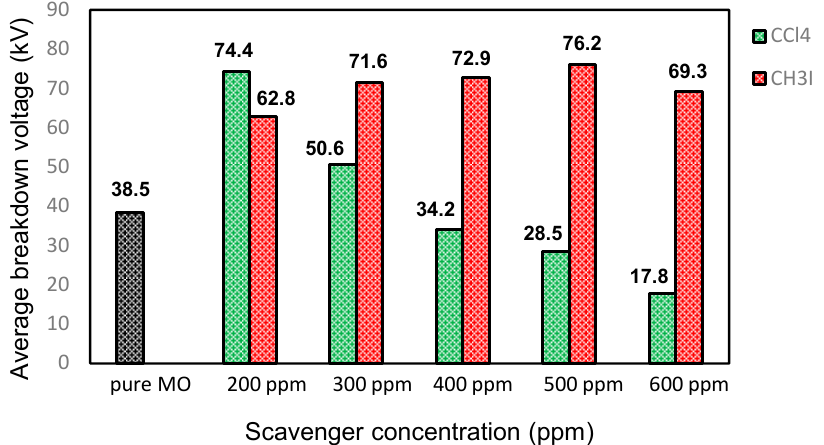
Figure 4. Comparison between the average AC breakdown voltage of the MO and those of the MO with different CH 3 I concentrations.